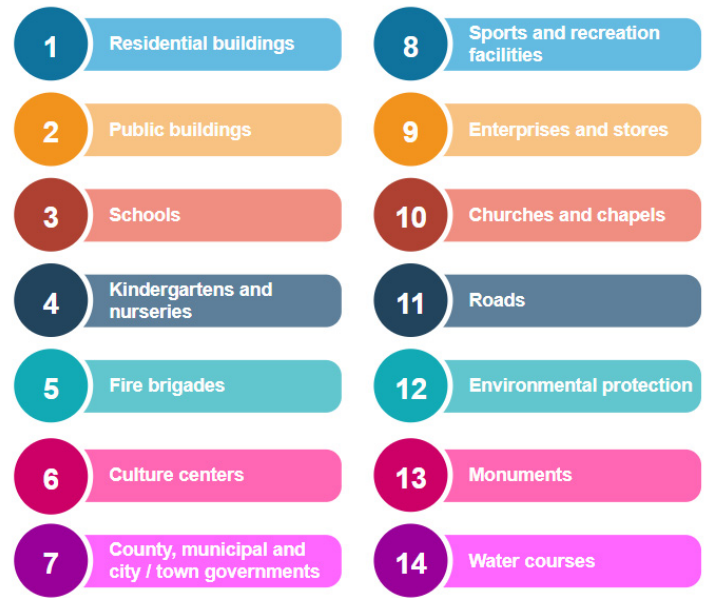
Figure 2. The list of objects occurring in mapping areas. Source: the authors’ own study.